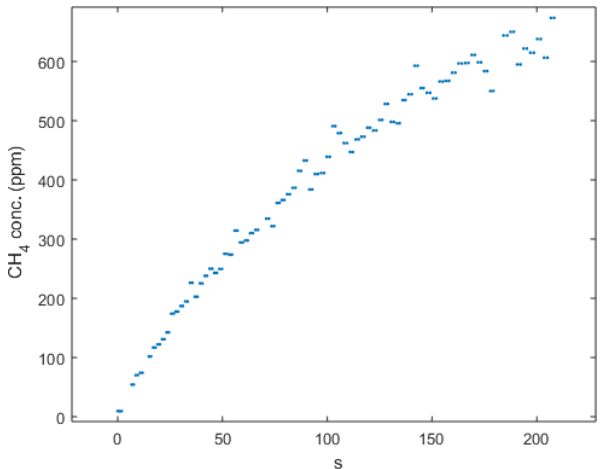
Figure B2. Chamber measurement during the September hotspot in the Tam-N location. Note the steady increase in concentration that indicates that ebullition was not the reason for the high magnitude of the flux at this